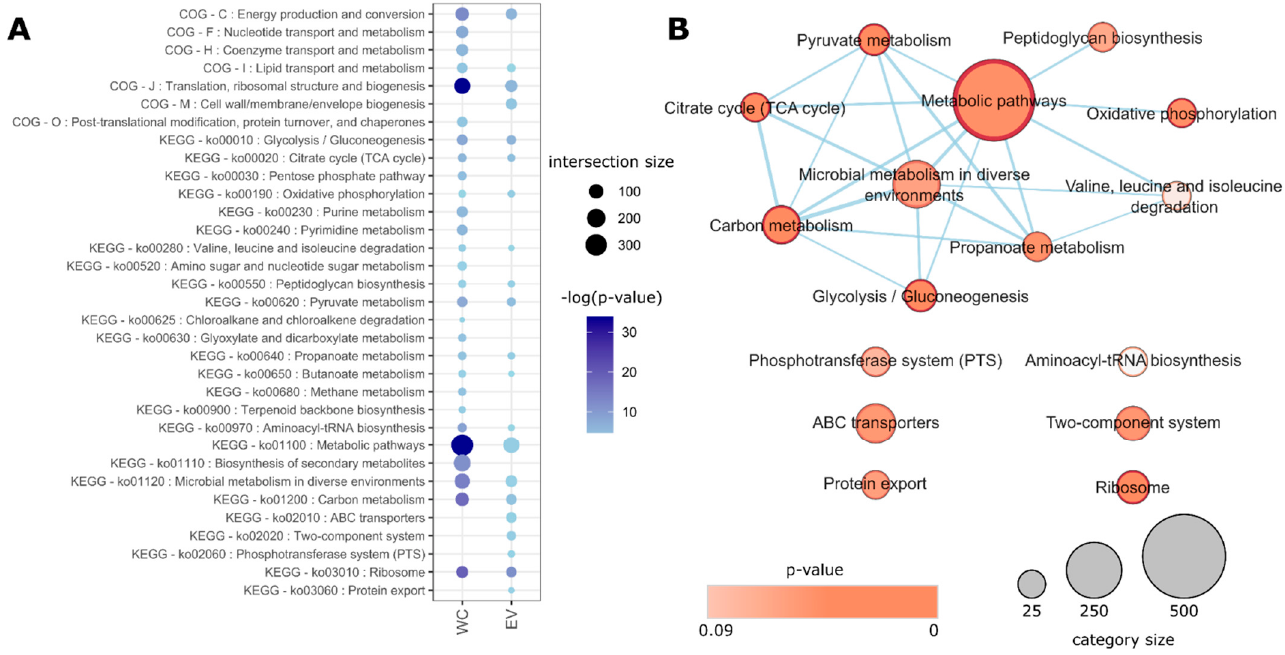
Figure 3. KEGG and COG categories that are enriched in S. aureus HG003 WC and EV proteomes. ( A ) Significantly enriched COG and KEGG terms that were associated with WC and/or EV groups. Darker colors represent more significant p -values (in logarithm scale) and bubble sizes represent the number of proteins in that category that were identified in the respective sample (the intersection size). ( B ) Enrichment map for EV-related KEGG terms, showing significant functional categories, their total sizes, and relationships (protein sharing).